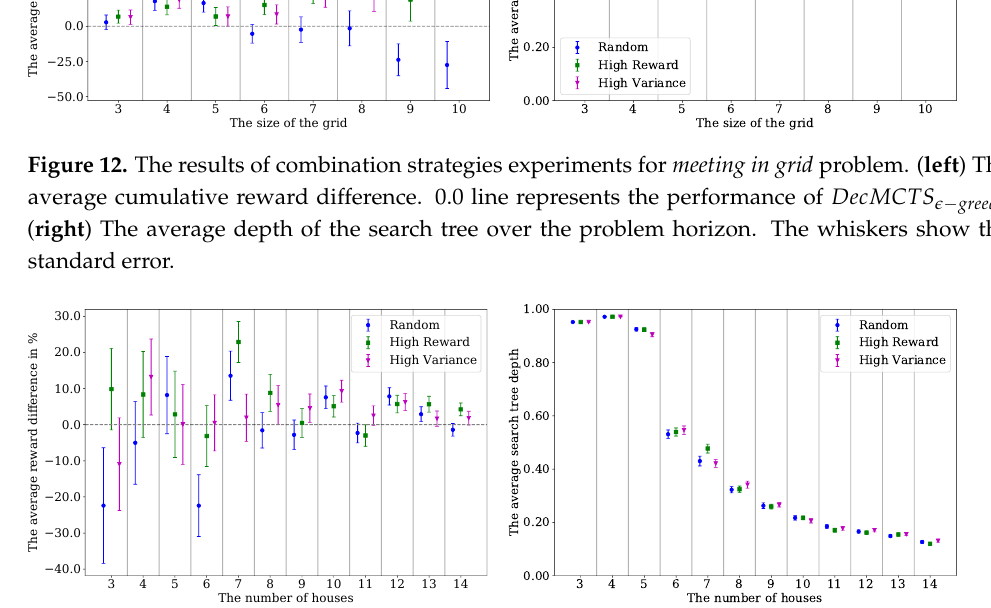
Figure 13. The results of combination strategies experiments for fire fighting problem. ( left ) The average cumulative reward difference in %. 0.0 line represents the performance of DecMCTS (cid:101) ( right ) The average depth of the search tree over the problem horizon. The whiskers show the standard